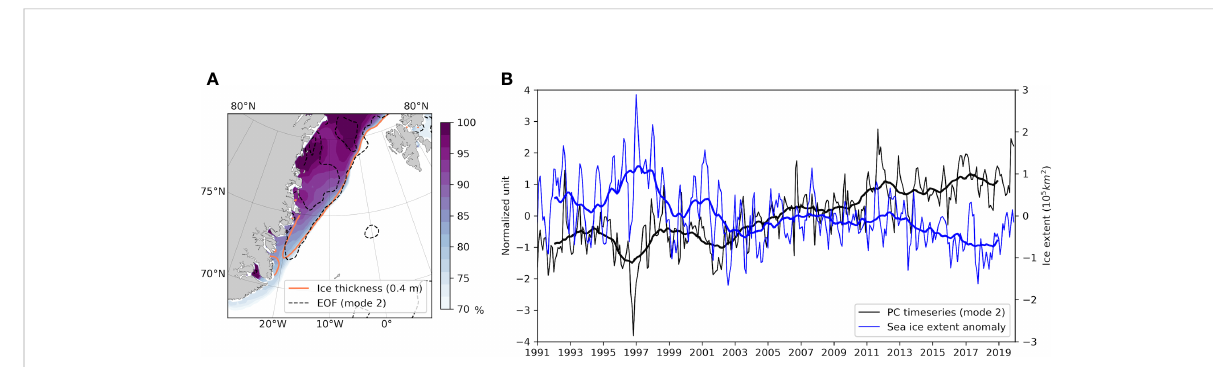
FIGURE 9 (A) Frequency of sea ice concentration over 0.15. The solid and dashed line represents the contour of mean ice thickness of 0.4 m and the second EOF mode of 0.1 intervals from -0.3 to 0 psu respectively. (B) Time series plot of principal component (PC) of the second mode and sea ice extent anomaly during the period of 1991-2019. The thick line represents the 25-month running mean of each time